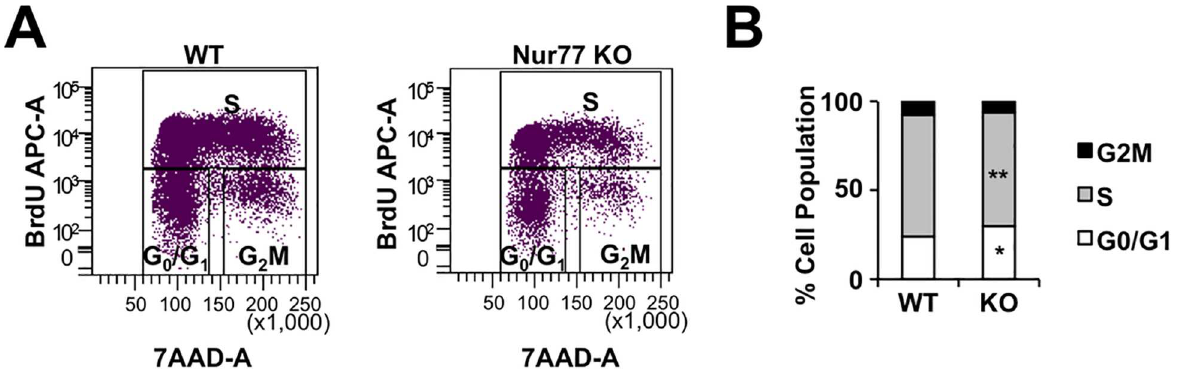
Fig 5. Cell cycle analysis of Nur77 -/- myogenic stem cells. (A) Measurement of wildtypeand Nur77 knockout cells incorporating BrdU as a function of total DNA content. (B) Relativeproportionof cells in different phases of cell cycle. N = 5. * P < 0.05, ** P <